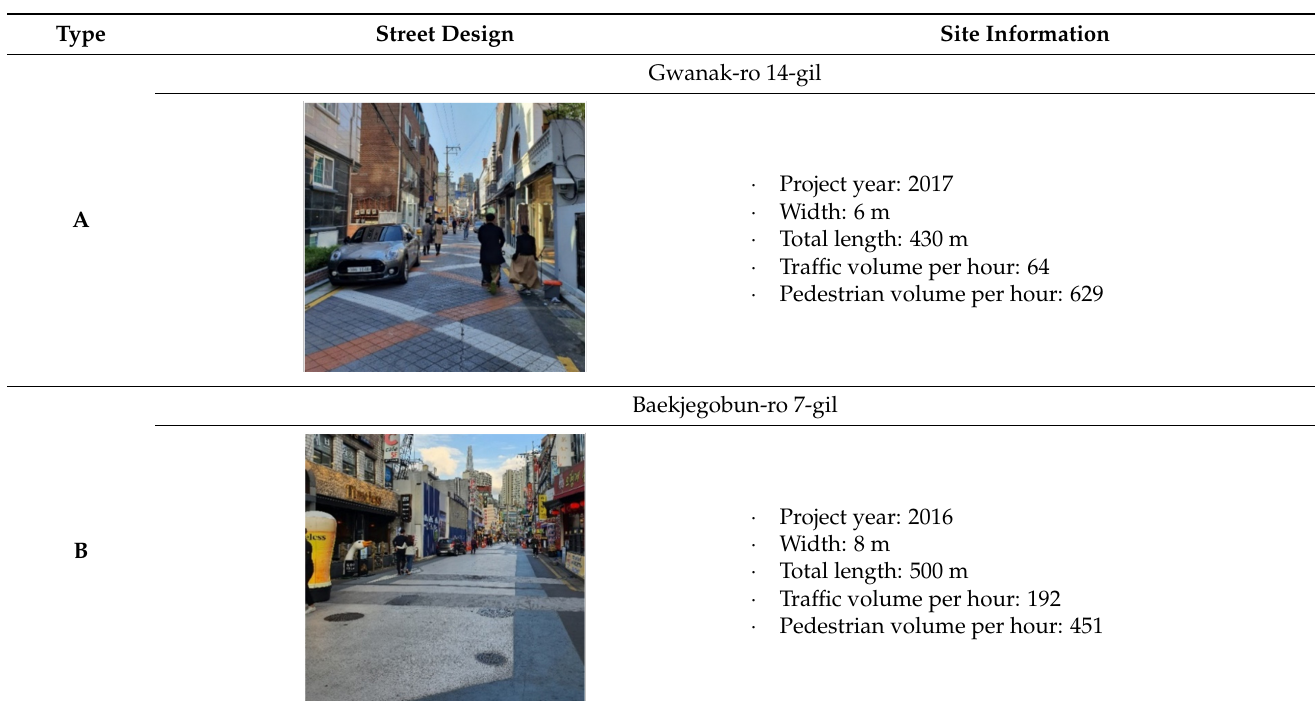
Table 2. Details of the study